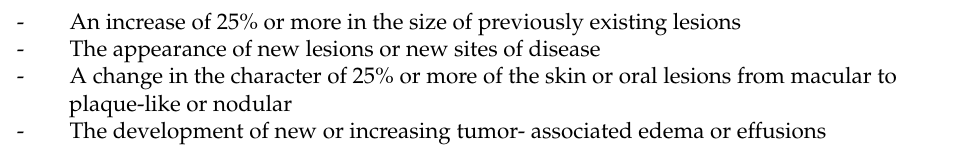
Table 3. Disease progression criteria according to ACTG response criteria (Krown et al., 1989)